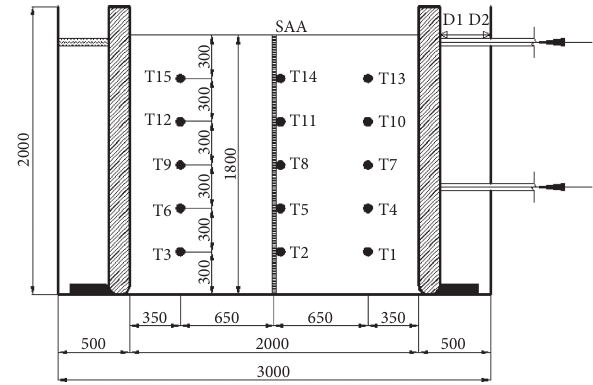
Figure 13: Arrangement of sensors embedded in observation section for quasistatic test (units: mm) (D: LVDT; T: earth pressure cell; SAA: shape acceleration array).